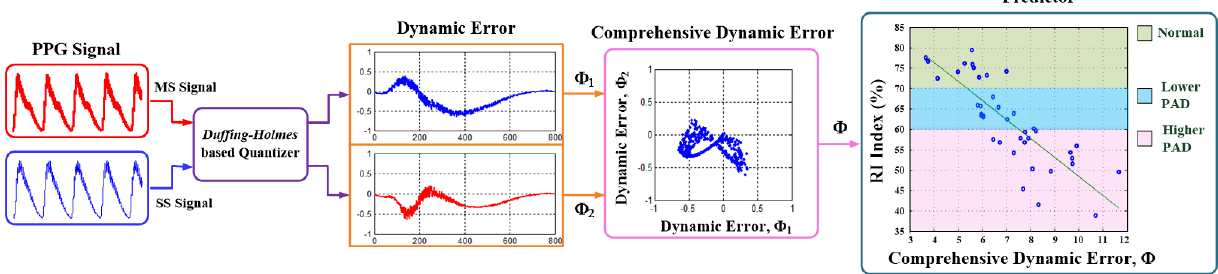
Figure 2. Duffing-Holmes (D–H)-based quantizer for feature extraction from normal and abnormal PPG signals.